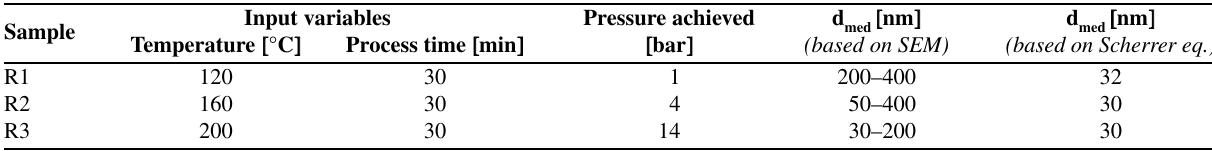
Table 3. Parameters of dehydration processes carried out in laboratory pressure reactor Sample